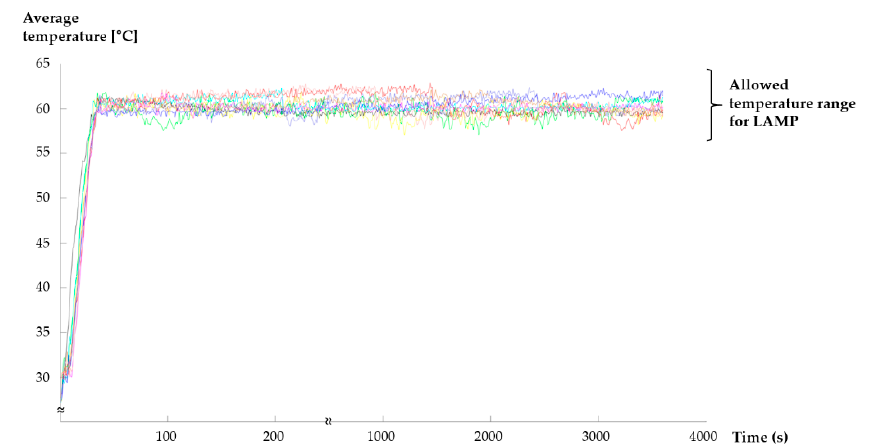
Figure 9. Graph showing that the amplification chamber reached approximately 60 °C in <1 min (resolution: 0.1; maximum value: 62.9; minimum value: 57.0).